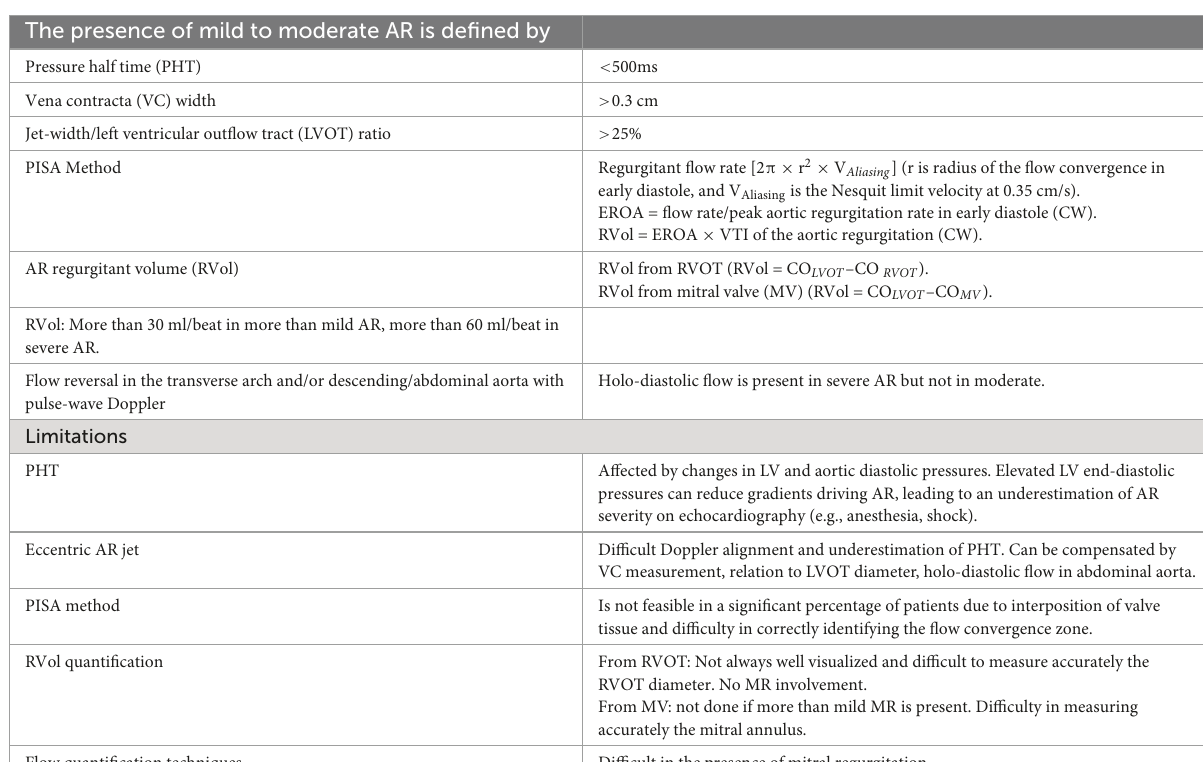
TABLE 4 Aortic regurgitation (AR) evaluation pre-left ventricular assist device (LVAD) implantation (78, 121–123). The presence of mild to moderate AR is defined by Pressure half time (PHT) < 500ms Vena contracta (VC) width > 0.3 cm Jet-width/left ventricular outflow tract (LVOT) ratio